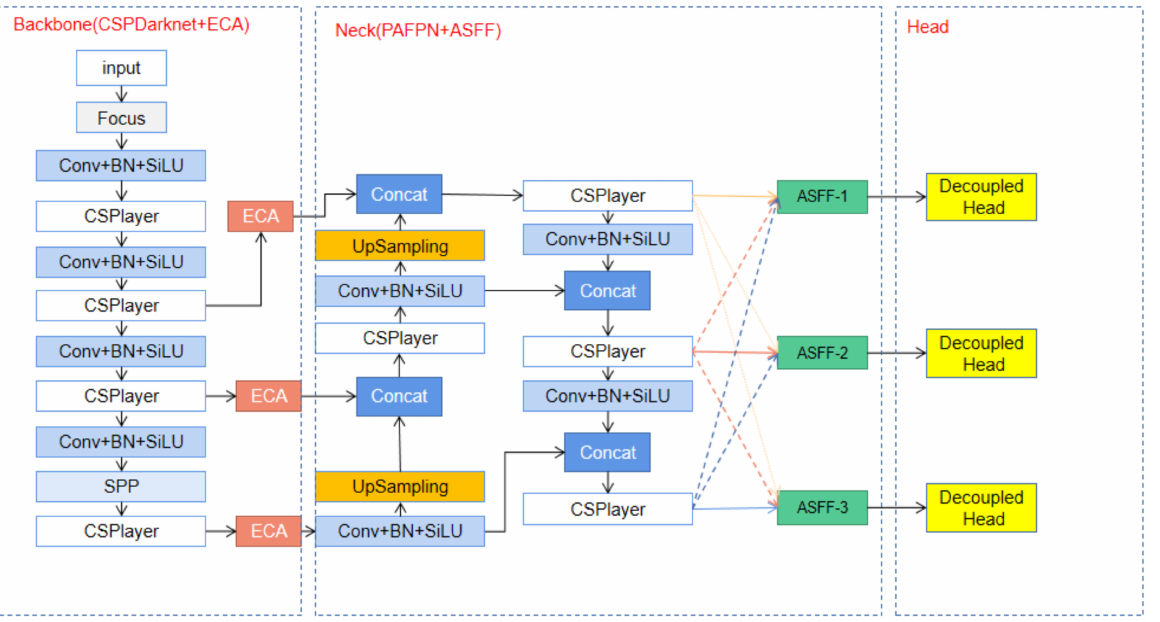
Figure 2. Structure of our improved YOLOX